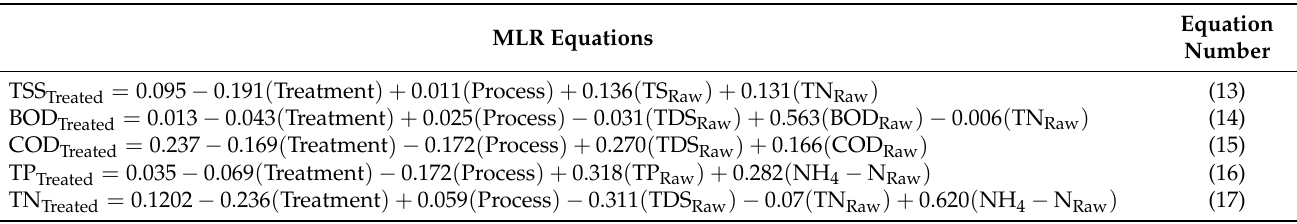
Table 2. MLR equations for predicting treatment effluent water quality of wash-water treatments. MLR